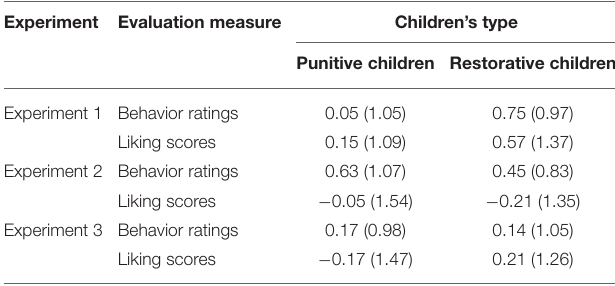
TABLE 2 | Means (standard deviations) of difference scores on behavior ratings TABLE 1 | The number (proportion) of children who gave stickers to the punisher and liking scores in experiment 1–3 as a function of children’s type (punitive or or the restorer in experiments 1–3. Gave the sticker to Gave the sticker to the the punisher restorer